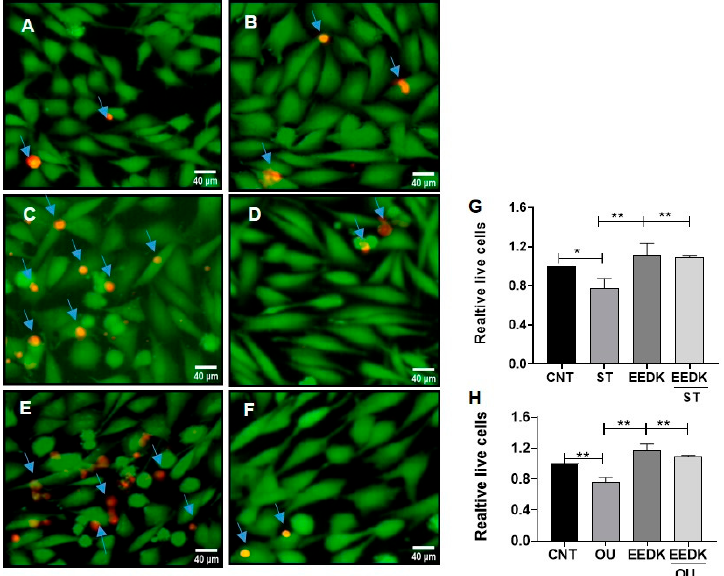
Figure 2. Live/dead imaging of HCECs exposed to cytotoxic drugs (ST and OU) with or without EEDK co-treatment. ( A , B ) Representative images of cells exposed to controls ( A ; no drug treatment, B ; EEDK treated cells) respectively. ( C , D ) Representative images of cells exposed to ST ( C ) and its co-treatment with EEDK 2 µg/mL ( D ). ( E , F ) Representative images of cells exposed to OU (E) and its co-treatment with EEDK 2 µg/mL ( F ). ( G , H ) Representative graphs for the ST and OU groups, respectively. Data are presented as the standard error mean ± SEM of values from four representative experiments. * p < 0.05, ** p < 0.01 for the indicated comparisons (one-way ANOVA with Tukey’s multiple comparison